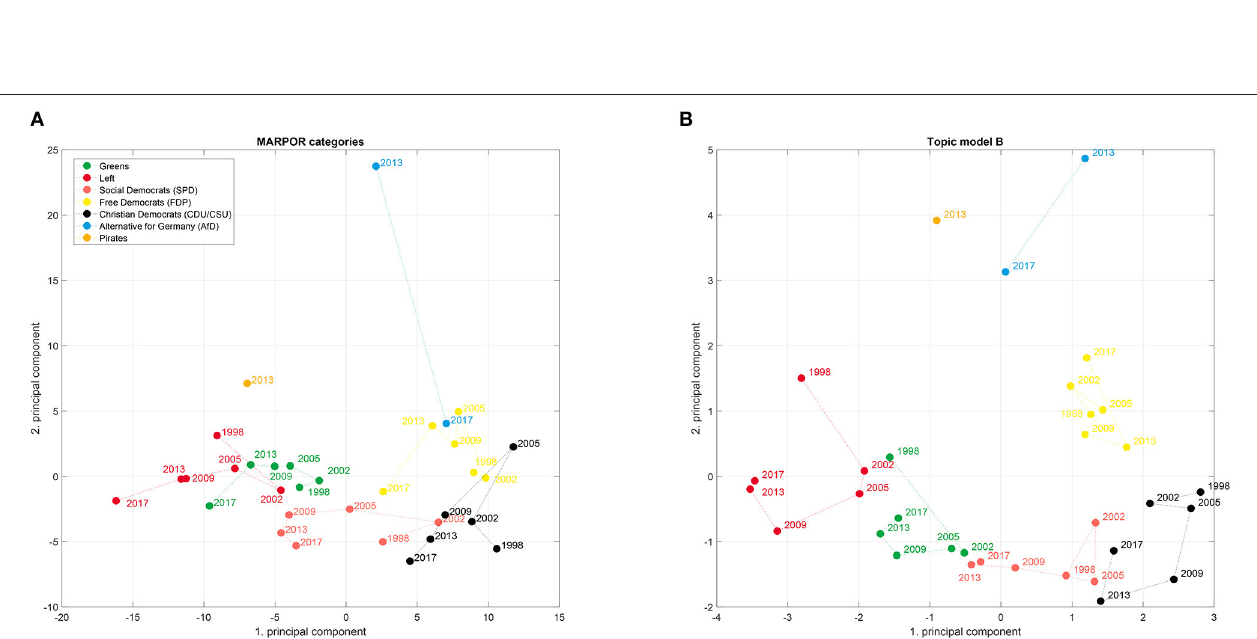
FIGURE 3 | Political spaces spanned by the first and second PCA component from the MARPOR counts (A) and for the topic model B (B) for Germany 1998–2017.